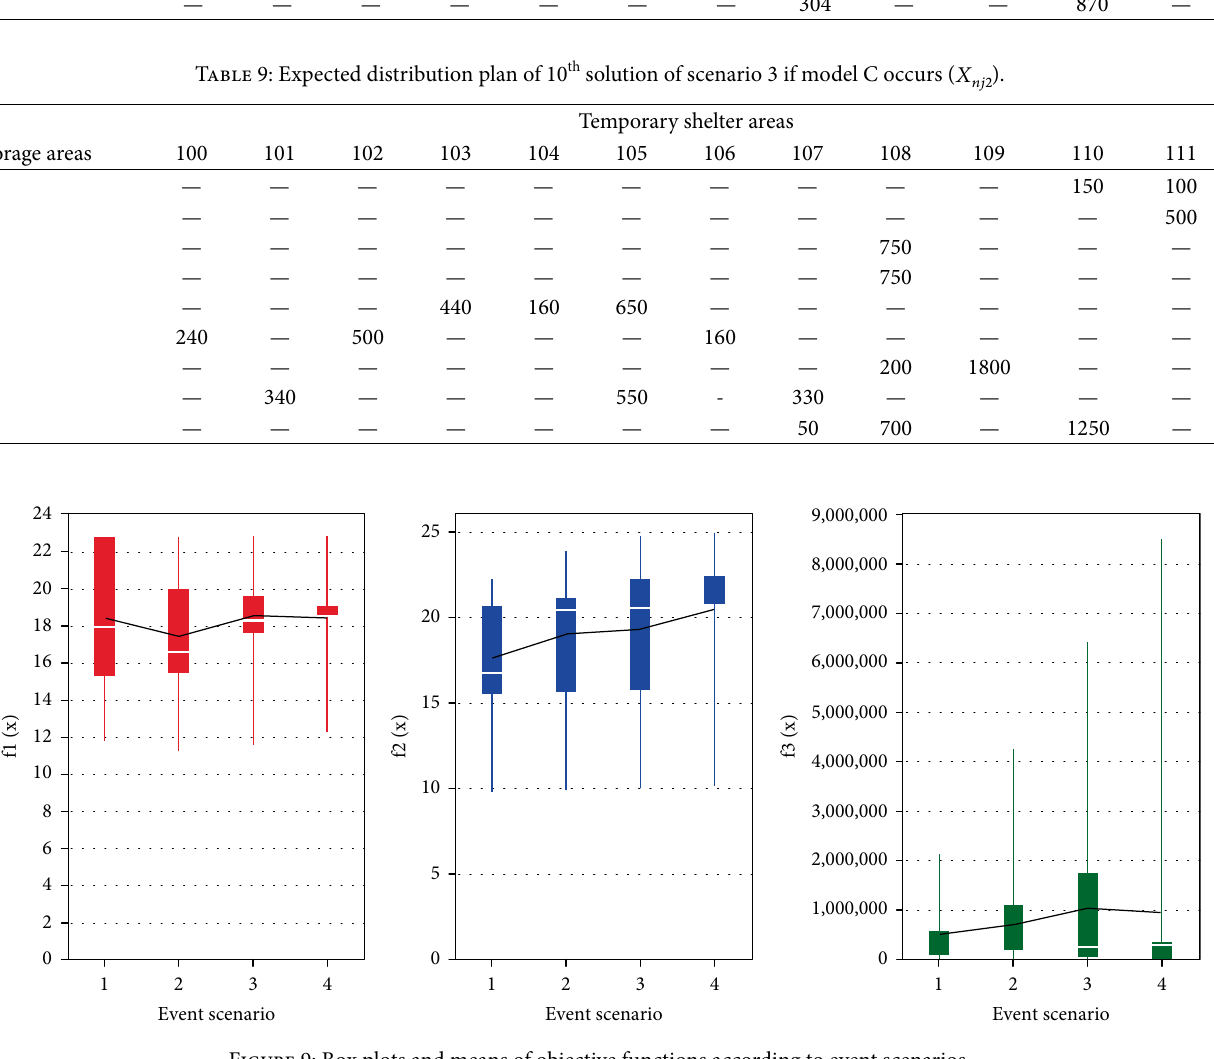
Figure 9: Box plots and means of objective functions according to event